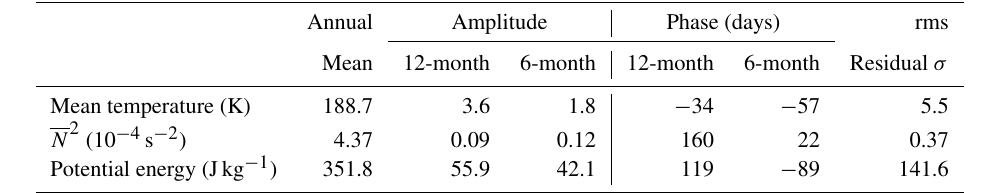
Table 2. Parameters of mean temperature, temperature variance, squared Brunt–Väisälä frequency, and potential energy averaged between 87 and 97km.